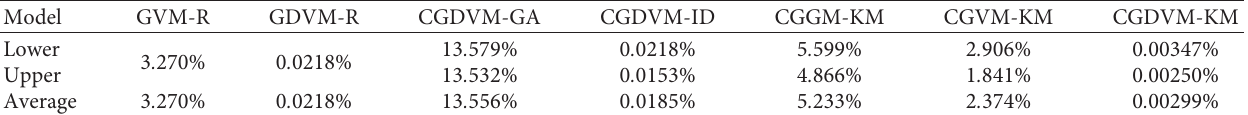
Table 5: Comparison of prediction error between this model and other grey prediction models.